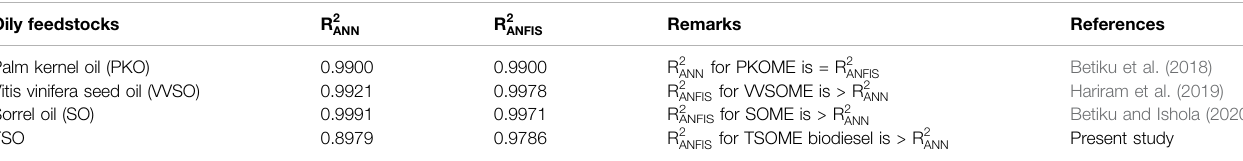
TABLE 6 | An overview on R 2 for ANN and ANFIS on TSOME with